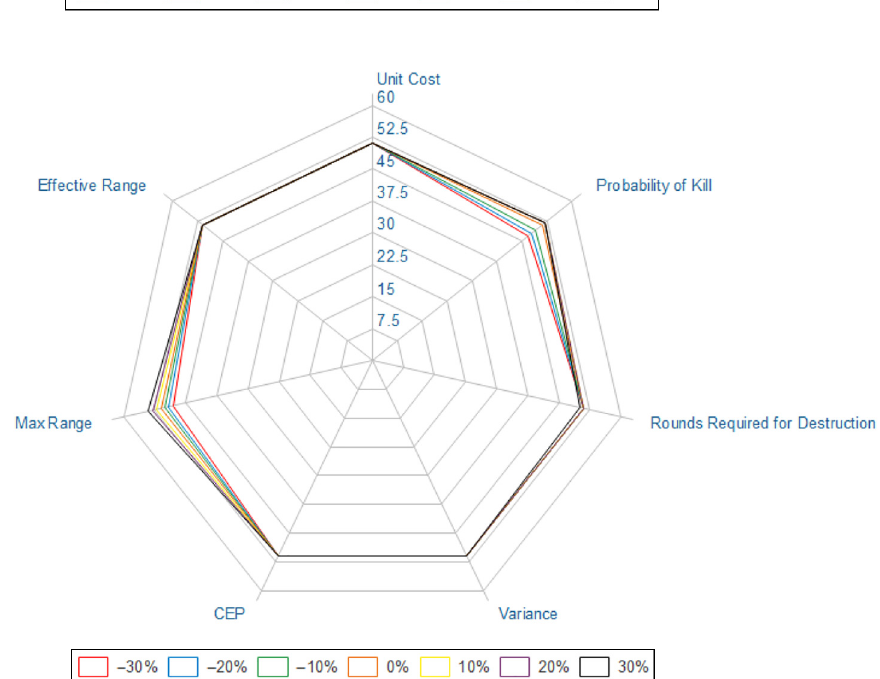
Figure 13. M549A1 total value sensitivity